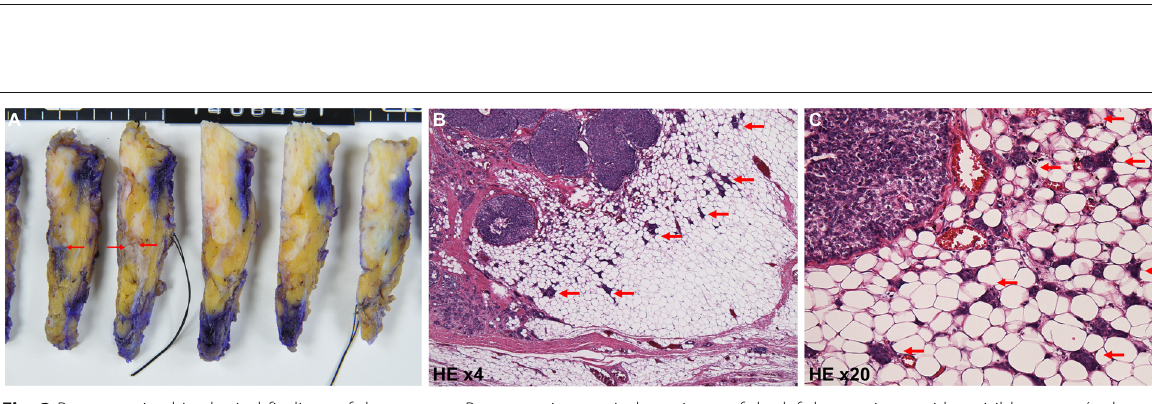
Fig. 3 Postoperative histological findings of the tumor. a Postoperative surgical specimen of the left breast tissue with a visible tumor (red arrow). b HE-stained section of the tumor at × 4 magnification. c HE-stained section of the tumor at × 20 magnification. The HE-stained sections illustrate a clear infiltration that suggests an invasive solid papillary carcinoma. The invasive components that spread out from the solid structure are visible (red arrow, b , c